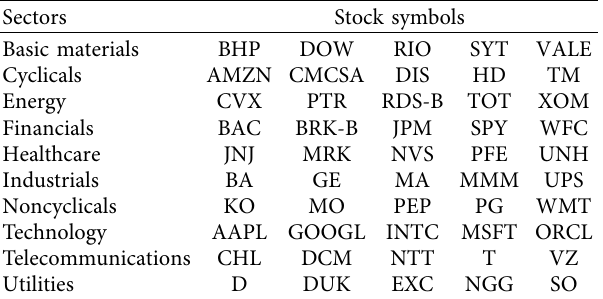
Table 1: Stock symbols of the dataset described in [12].